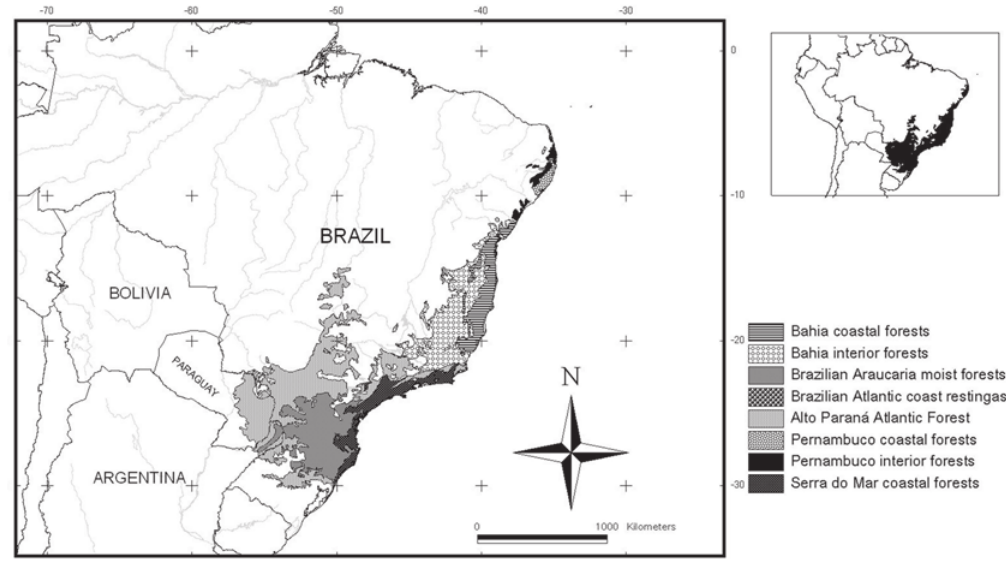
Figure 1. Atlantic Forest ecoregions (D INERSTEIN et al. 1995, O LSON et al.